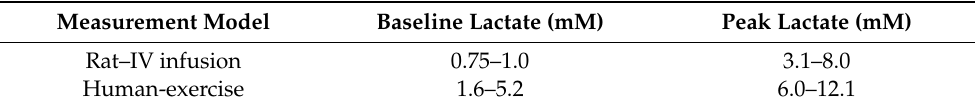
Table 1. Blood lactate levels observed during current monitoring